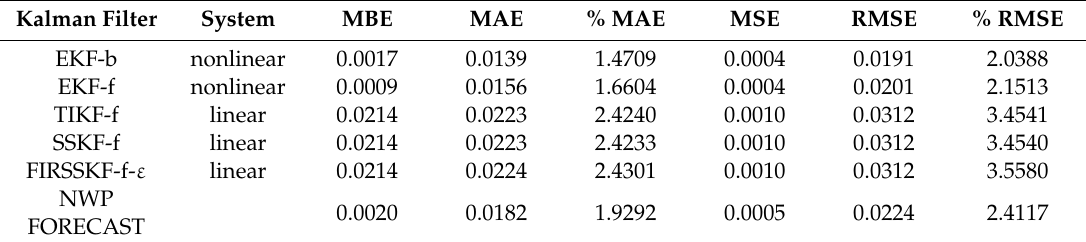
Table 1. E ffi ciency of KF prediction algorithms used in output power